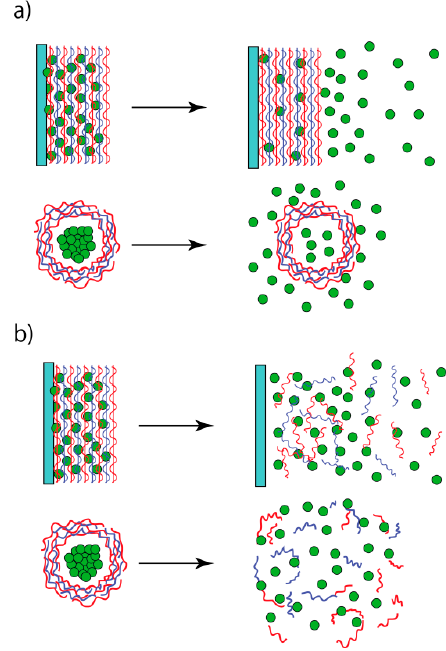
Figure 9. Drug release from LbL films and microcapsules through ( a ) permeability changes and ( b ) decomposition.